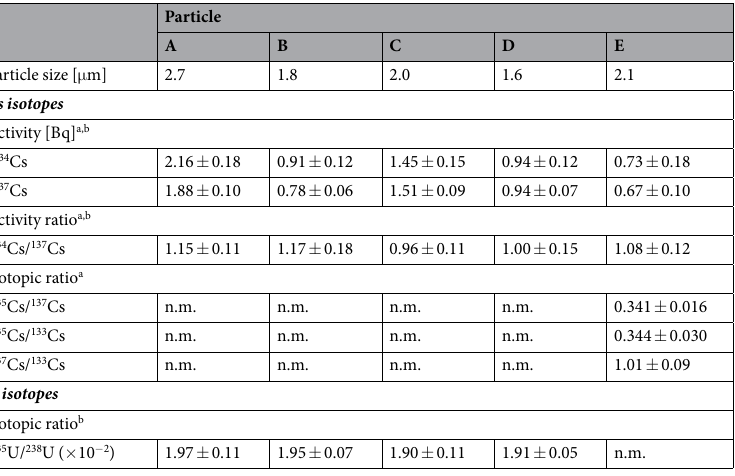
Table 1. Characteristics of the five CsMPs. a The values are decay-corrected as to March 11, 2011. b Error shows 1 σ standard deviation from counting statistics. c Error shows 1 σ standard deviation from five replicate measurements of a NIST SRM 610 standard glass. n.m.: Not